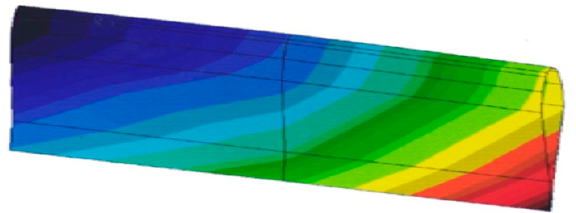
Figure 8. An 1800-element finite element torsional deflection model of a DAP wing at 200 µstrain of commanded free-strain deflections by DAP elements.